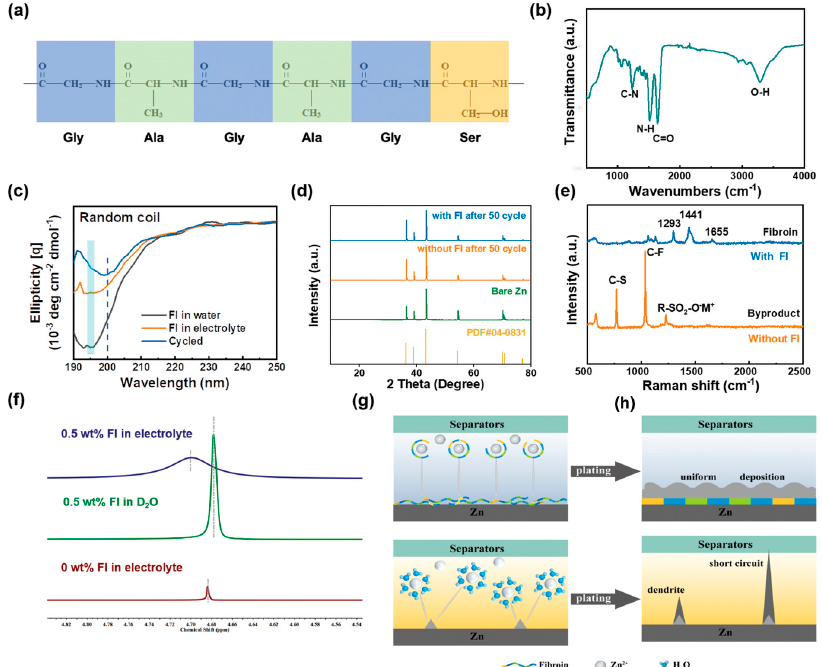
Figure 9. ( a ) Scheme of fibroin primary structure. ( b ) The Fourier transform infrared spectroscopy (FT-IR) spectrum of pristine fibroin. ( c ) The circular dichroic (CD) spectroscopy of FI in water, electrolyte, and cycled. ( d ) XRD patterns of the Zn electrodes after 50 cycles at 1 mA cm − 2 (0.5 mAh cm − 2 ) in different electrolytes. ( e ) Raman spectra of Zn electrodes deposited 100 cycles at 1 mA cm − 2 (0.5 mAh cm − 2 ) in different electrolytes. ( f ) Liquid-state 1H NMR spectra of different solutions with D 2 O as solvent. Schematics of Zn 2+ ion diffusion and reduction progress on the electrode in different electrolytes. ( g ) With FI additive. ( h ) Without additive. Reproduced with permissions from Ref. [59]. Copyright © 2022 WILEY-VCH.